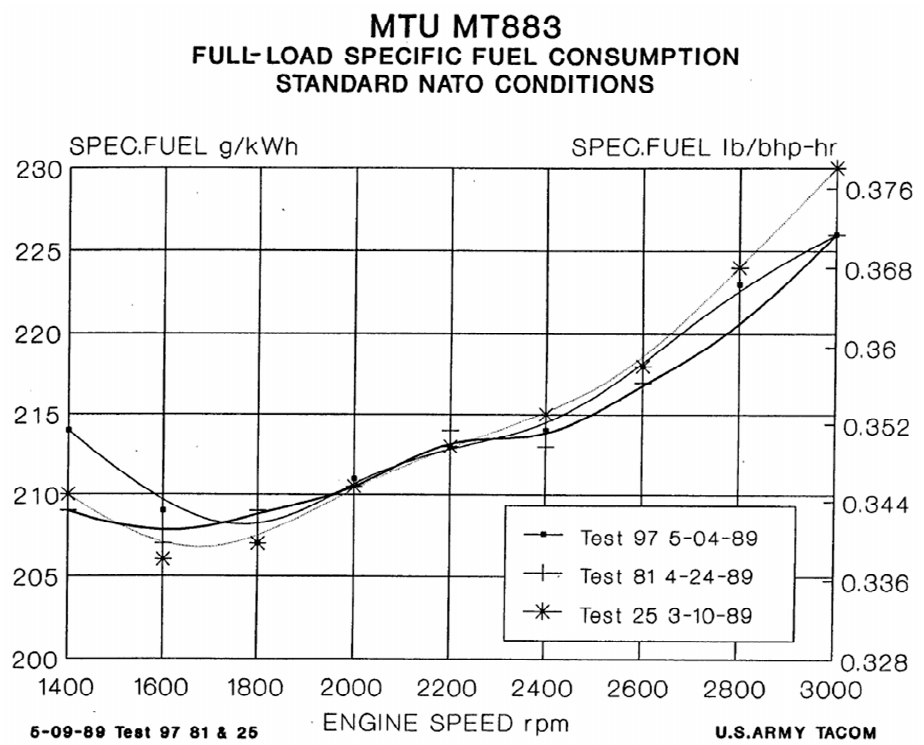
Figure 5. Brake Specific Fuel Consumption of a traditional MBT Engine [17].